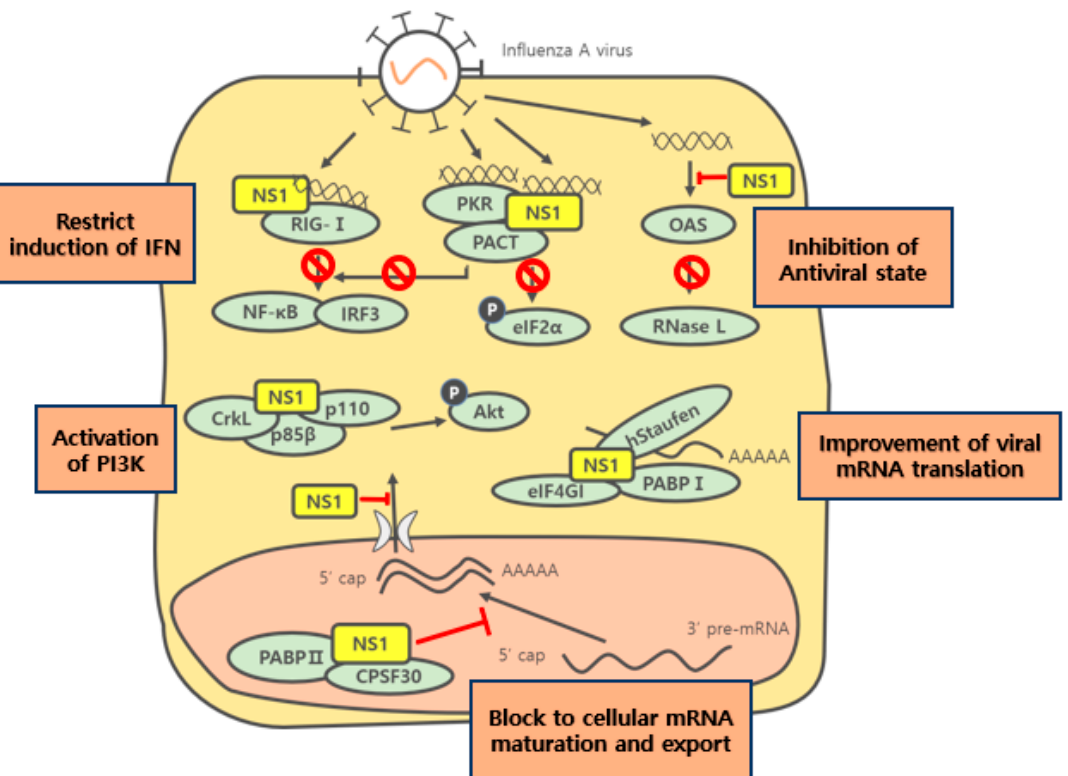
Figure 2. Overview of the functions of NS1 protein in cytoplasm and nuclei of infected cells. NS1 plays a vital role as an INF antagonist for the influenza virus. NS1 inhibits IFN induction at the pre-transcriptional stage by blocking the activation of the RIG-I and at the post-translational level by repressing activations of the antiviral properties of PKR and OAS/RNase L. Furthermore, NS1 disrupts the processing and nuclear export of cellular mRNAs. NS1 enhances viral mRNA translation, and activation of the PI3K pathway by NS1 is required for viral replication in infected cells.